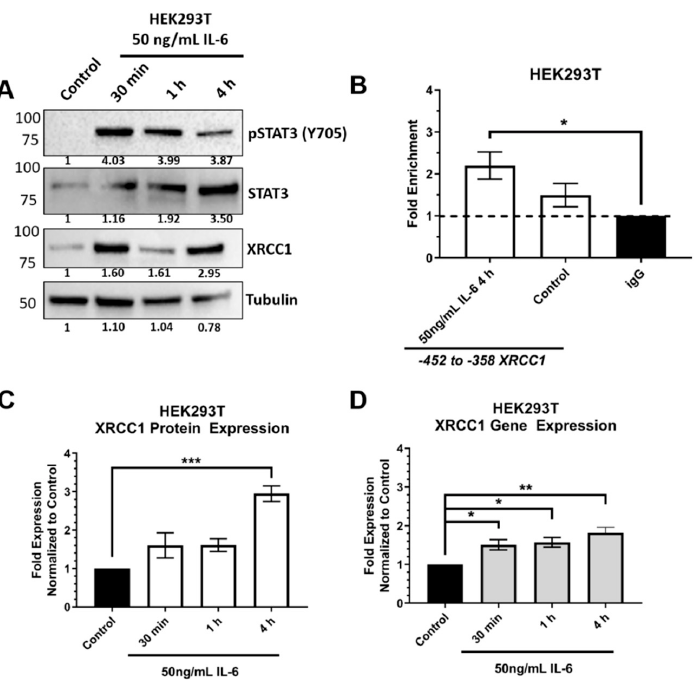
Figure 8. IL-6 increases phospho-STAT3, increases the occupancy of STAT3 at the XRCC1 promoter, and increases the expression of XRCC1 in HEK293T. ( A ) Representative immunoblot of phospho-STAT3 (Y705), STAT3 and XRCC1 protein expression after 30 min, 1 and 4 h of exposure to 50 ng/mL IL-6. α -tubulin is used as a loading control. ( B ) ChIP analysis shows that IL-6 increases the STAT3 occupancy on the XRCC1 promoter. ( C ) Quantification of protein expression changes in XRCC1 resulting from 50 ng/mL IL-6. ( D ) Quantification of XRCC1 mRNA expression following 50 ng/mL IL-6. * p < 0.05, ** p < 0.01, *** p <